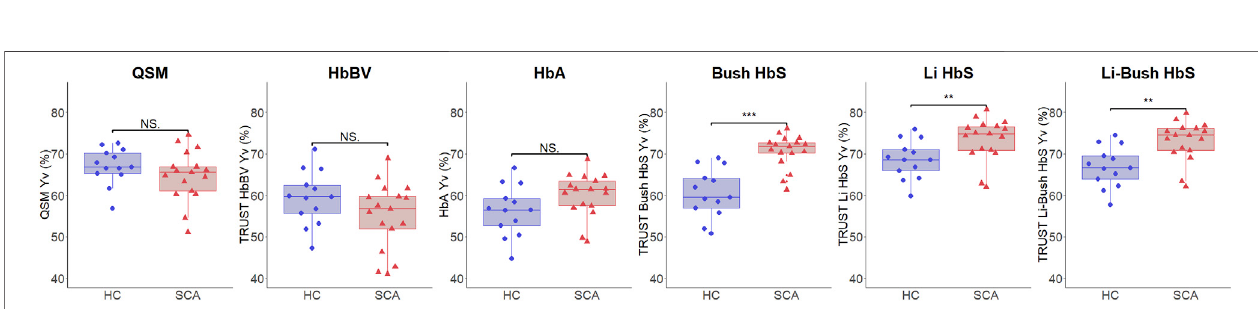
FIGURE5| Groupwisecomparisonofmeanvenousoxygensaturation(Y v ,%,y-axis)measuredinthesuperiorsagittalsinusinsicklecellanemia(SCA)andhealthy control (HC) subjects. One graph isshown for QSM of Y v , and TRUST-based Y v measures with fi ve different calibration models. Mean differencesbetween groups were examined by t-test: NS: no signi fi cant difference, ** p < 0.01, *** p < 0.005.